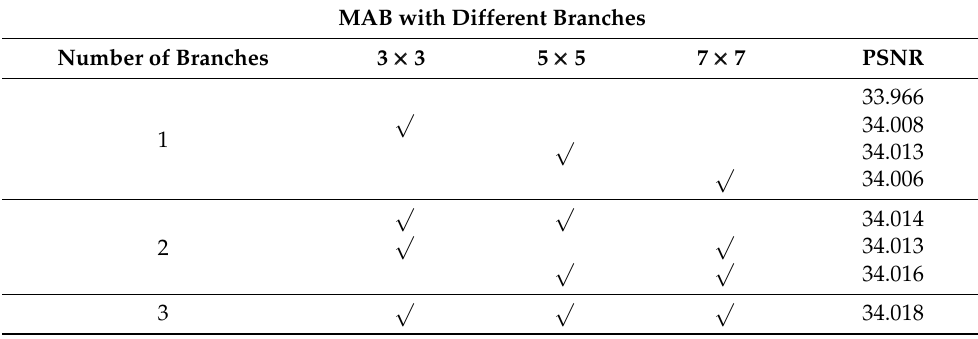
Table 2. The effectiveness of MAB with different branches on the model. We compared the results of our MAB with different branches after 2 × 10 5 iterations on the validation set for × 2 scale SR.